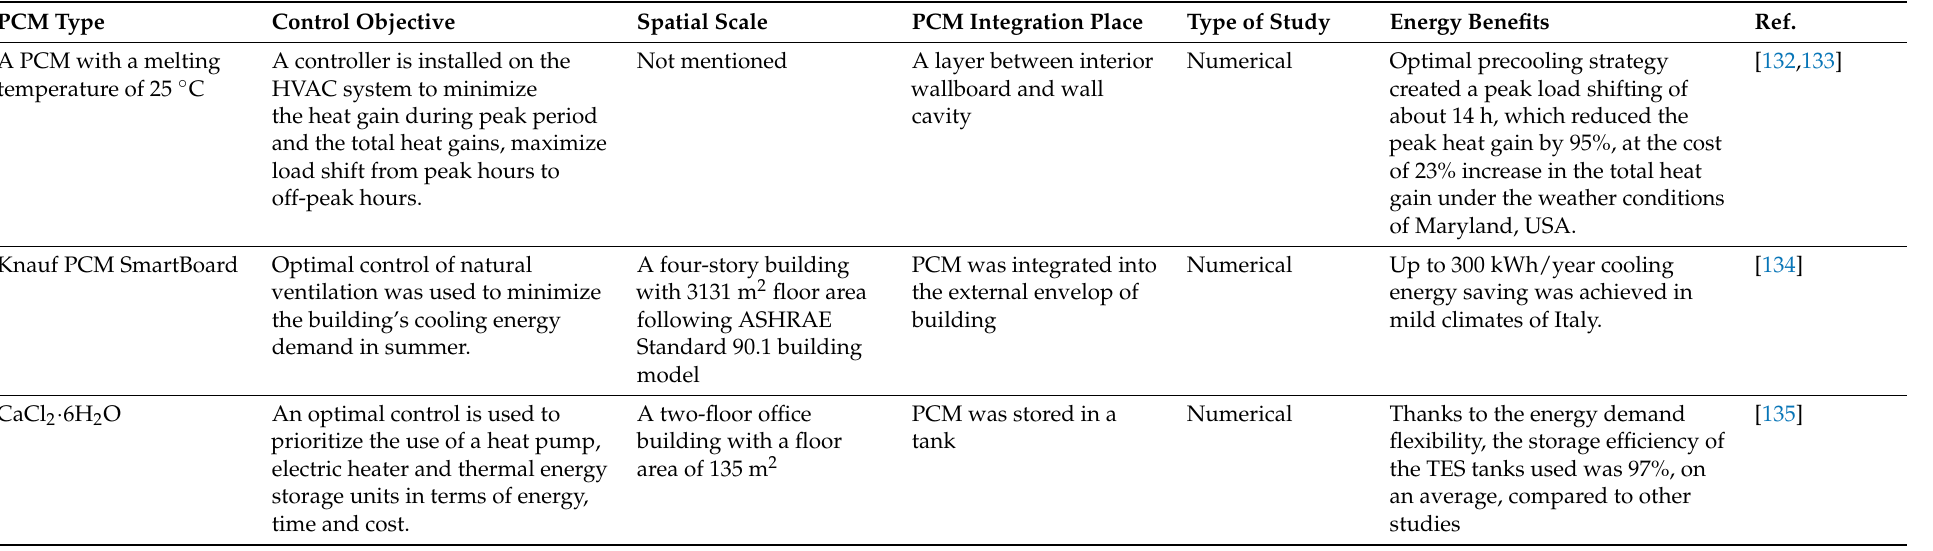
Table 5. Application of ON/OFF controller in PCM-enhanced buildings used for peak load